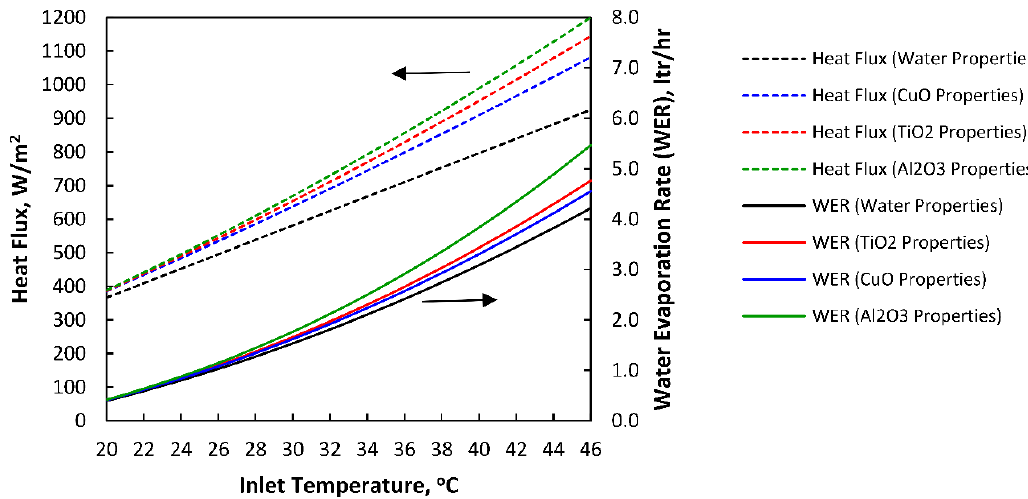
Figure 7. Influence of nanofluids on heat flux and water evaporation rate.